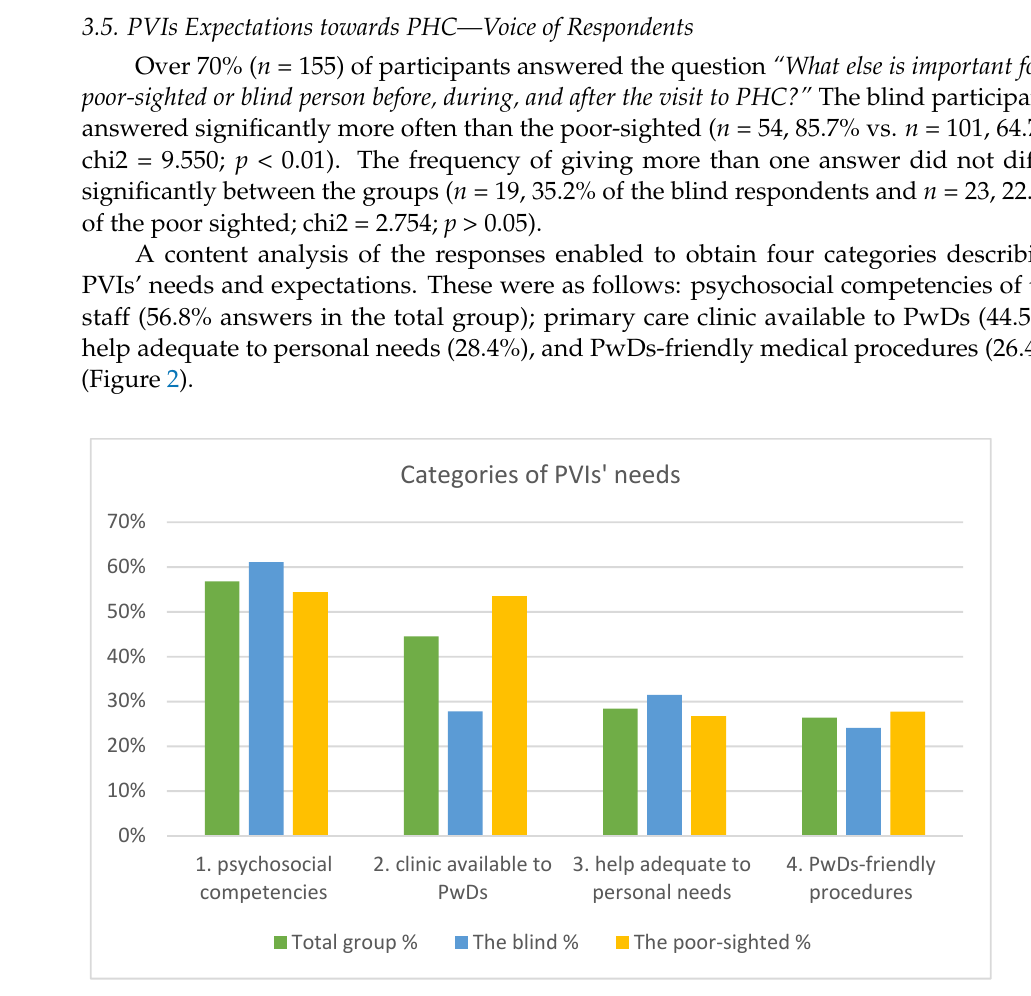
Table 3. Psychosocial competencies of staff as desired by patients with VIs. Non-Verbal Aspects of Communication An eye contact “I will feel that the doctor is discounting me unless he looks at my eyes.” Touch “I have a very good PCP doctor—when he says “good morning” to me he shakes my hand or touches my shoulder—then I know he is talking to me.” Voice messages and their quality “(...) I remember one appointment I went to with my wife. The doctor did not speak at all until I had to ask my wife if the doctor was in the office. But he was. After that, he started to speak.” “[it is important] for the doctor to speak carefully. People with good vision do not realize that eye contact during a conversation plays a big role in understanding what the speaker is saying (...).” “I read the other person’s lips so the current situation where the doctor wears a mask at the appointment [in relation to the COVID-19 pandemic] is uncomfortable for me, I don’t often understand, the sound then is also different and I ask the doctor to repeat”(deaf-blind woman). Communication through written words—PVIs need: “PCP to print out all information on a computer in black and white rather than write it down on a piece of paper by hand.” “PCP to fully explain the treatment procedure and clearly write (or print) the dosage and names of medications taken during the treatment.” “Well done website and detailed description.” Medical staff attitude toward patients with VIs Equal treatment by direct communication “I wish doctors would talk to us—the blind and not ignore us and instead talk about us to the person we came with. When I am at the doctor’s with my son—I can understand it, but if I am with an assistant—I cannot stand it. They treat us as if we are mentally handicapped, as if we have mental limitations. I feel like an invalid patient, it’s embarrassing and humiliating. Assistants do not want to enter the office with us, so that we are not treated in such a way. When we are left alone with the doctors, they have no choice but talk to us. But this is not a solution either. If I have a lot of different documents on me and I do not know which ones I am supposed to hand in and, in which order, I need such a